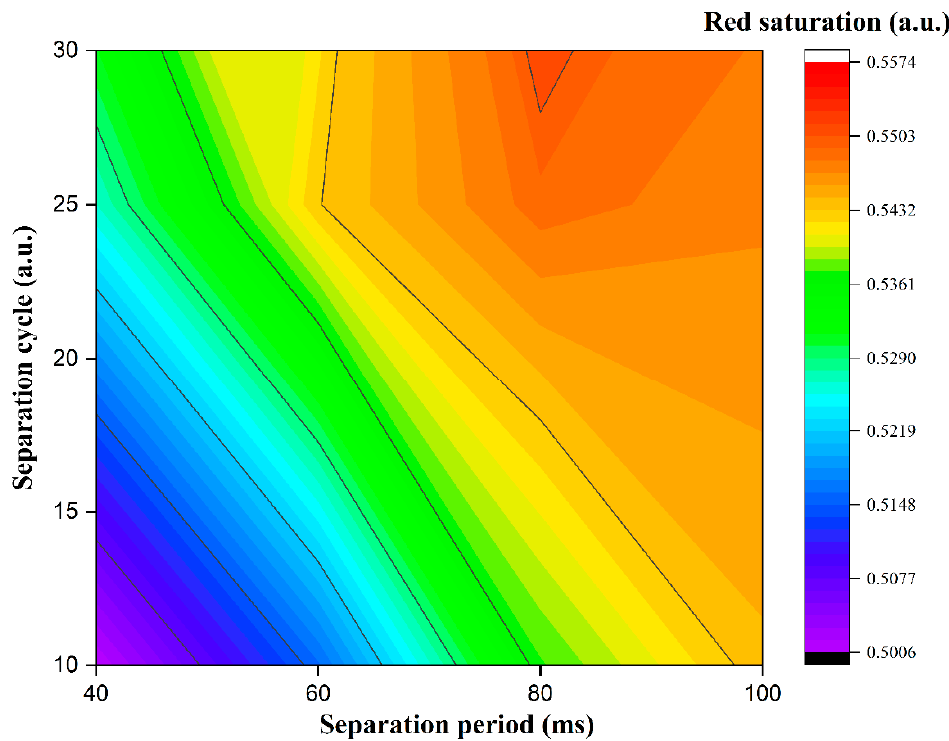
Figure 4. The relationship between red saturation values and separation stage parameters. The red saturation had an increasing trend when the separation period and cycle were increased. The maximum value was 0.55 when the separation period was 80 ms and the separation cycle was 30. The minimum value was 0.50 when the separation period was 40 ms and the separation cycle was 10.